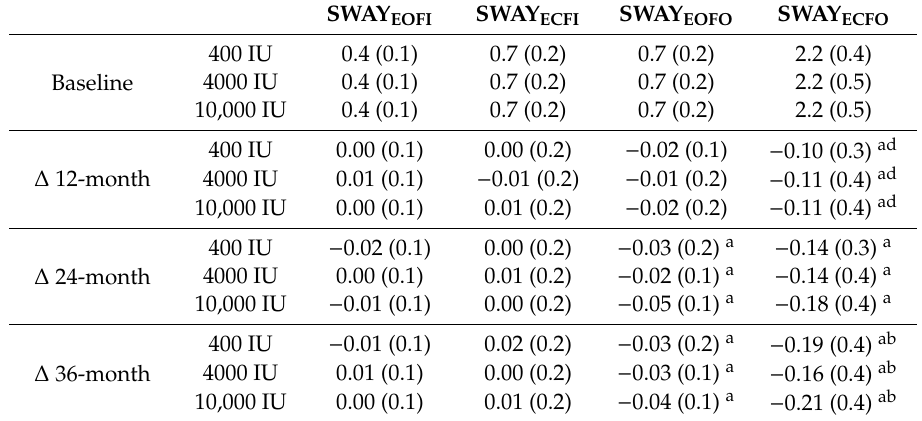
Table 3. Adjusted mean absolute difference (95% confidence interval) in sway indices between treatment groups using linear mixed effects modeling. Table 2. Baseline and absolute mean change (SD) from baseline by treatment groups for sway index. SWAY EOFI SWAY ECFI